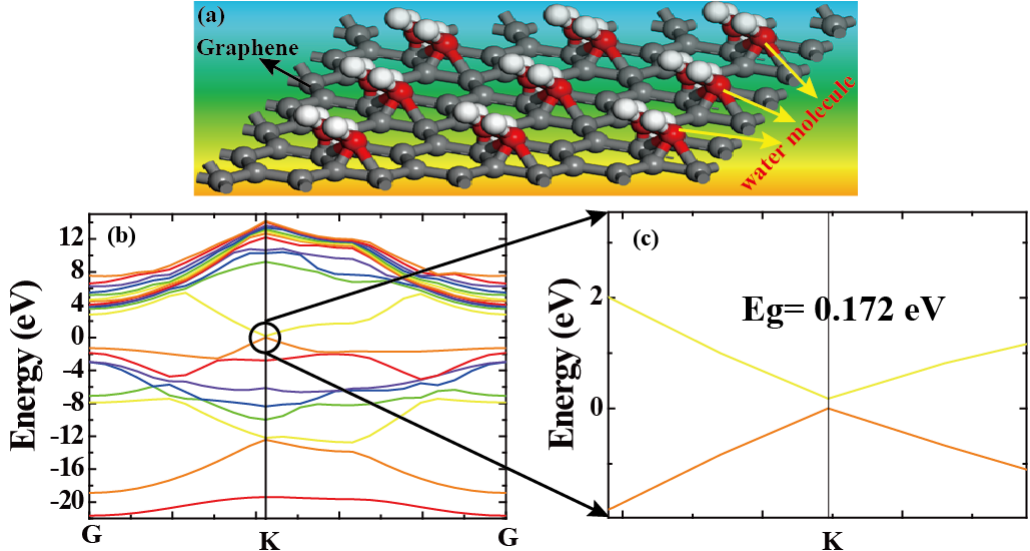
Figure 5. ( a ) The bonding mechanism between the graphene and water molecules. ( b ) The electronic band structure of graphene decorated with water. ( c ) The energy gap at the K point location.